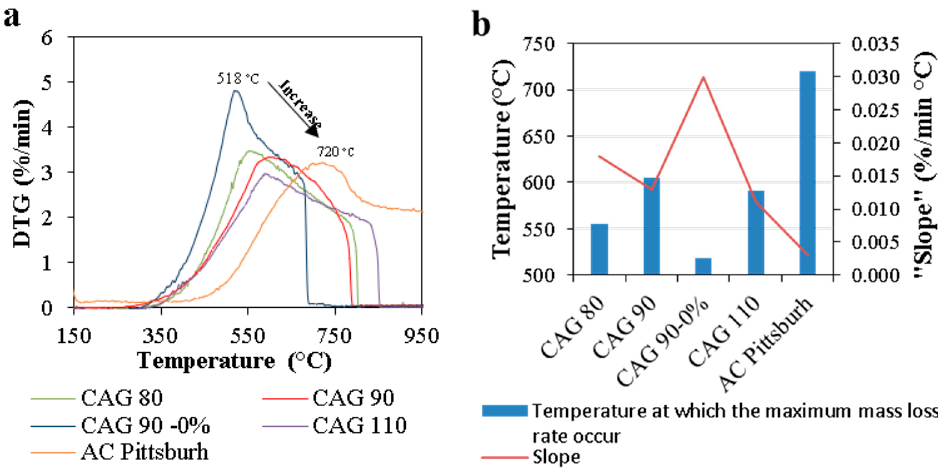
Figure 4. DTG for thermal resistance in air with heating rate: 10 °C/min; air flow: 80 mL/min ( a ). Comparison between thermal resistance indicators in chars’ samples ( b ).